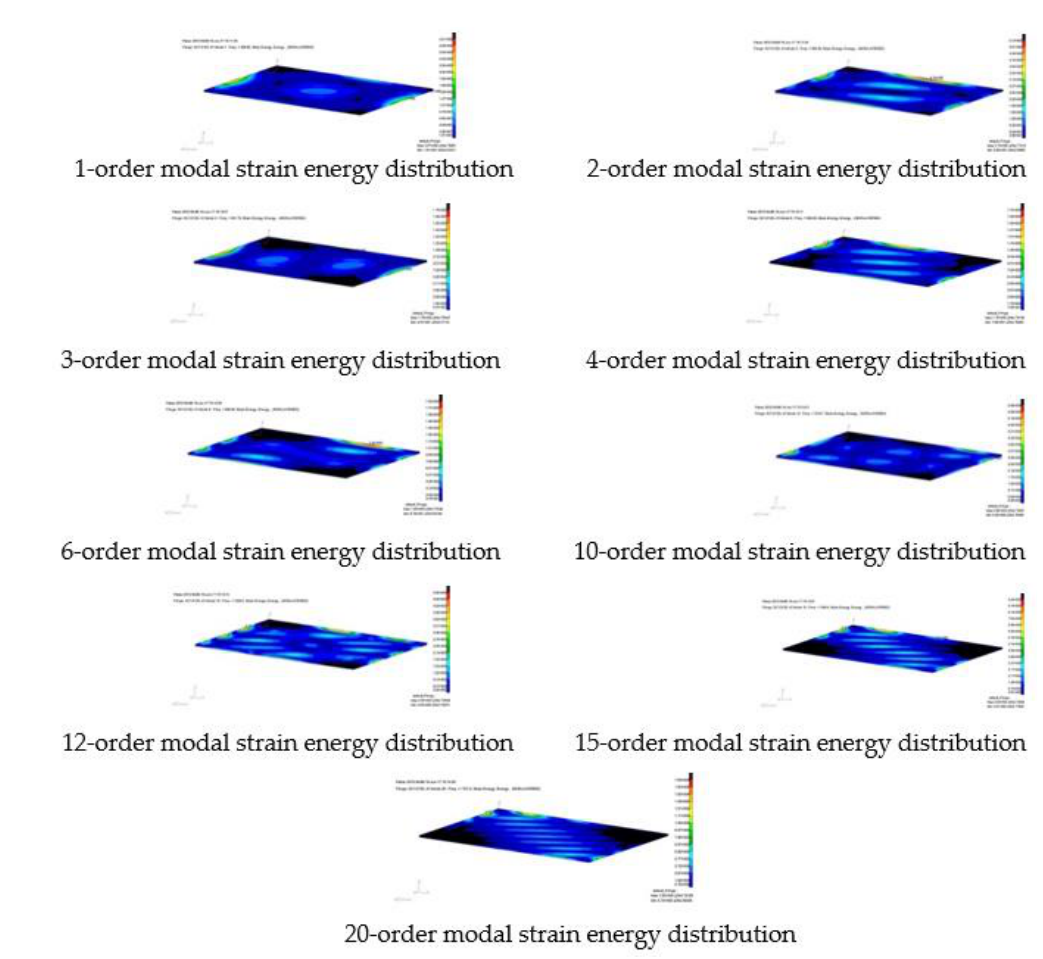
Figure 4. The typical strain energy of the composite plate.